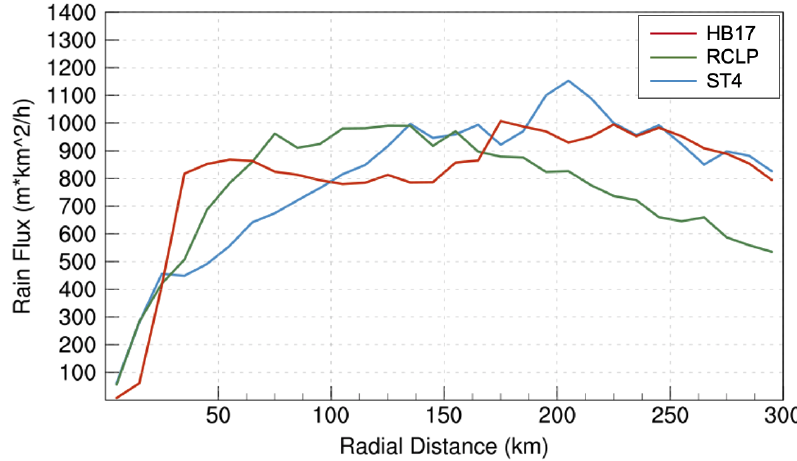
Figure 8. Radial distribution of rain flux of Hurricane Harvey. Similar to Figure